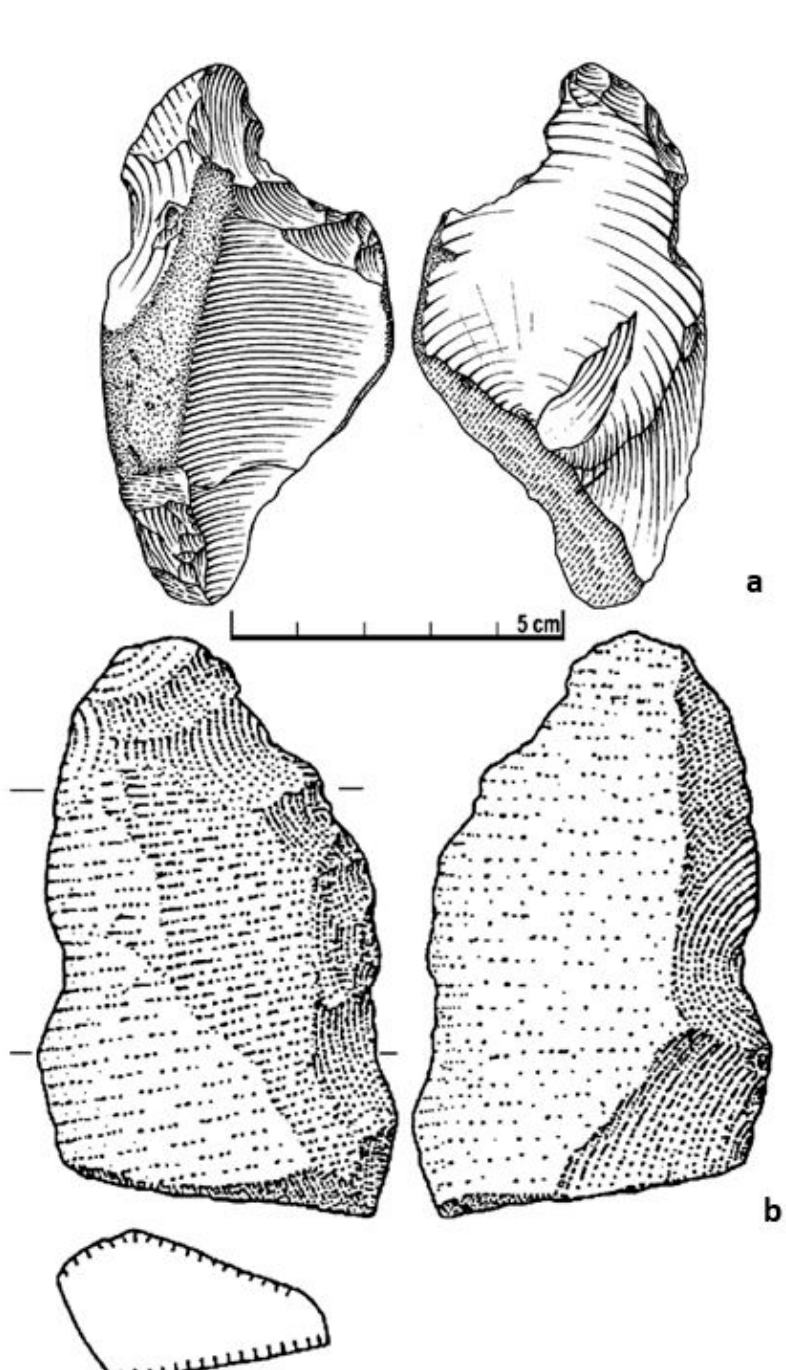
Figure 24. Dorsten-Schermbeck, in situ finds. ( a ) Clacton flake with distal notches (flint); ( b ) side scraper out of a shattered quartzite. (Drawing: B. Kaletsch.).